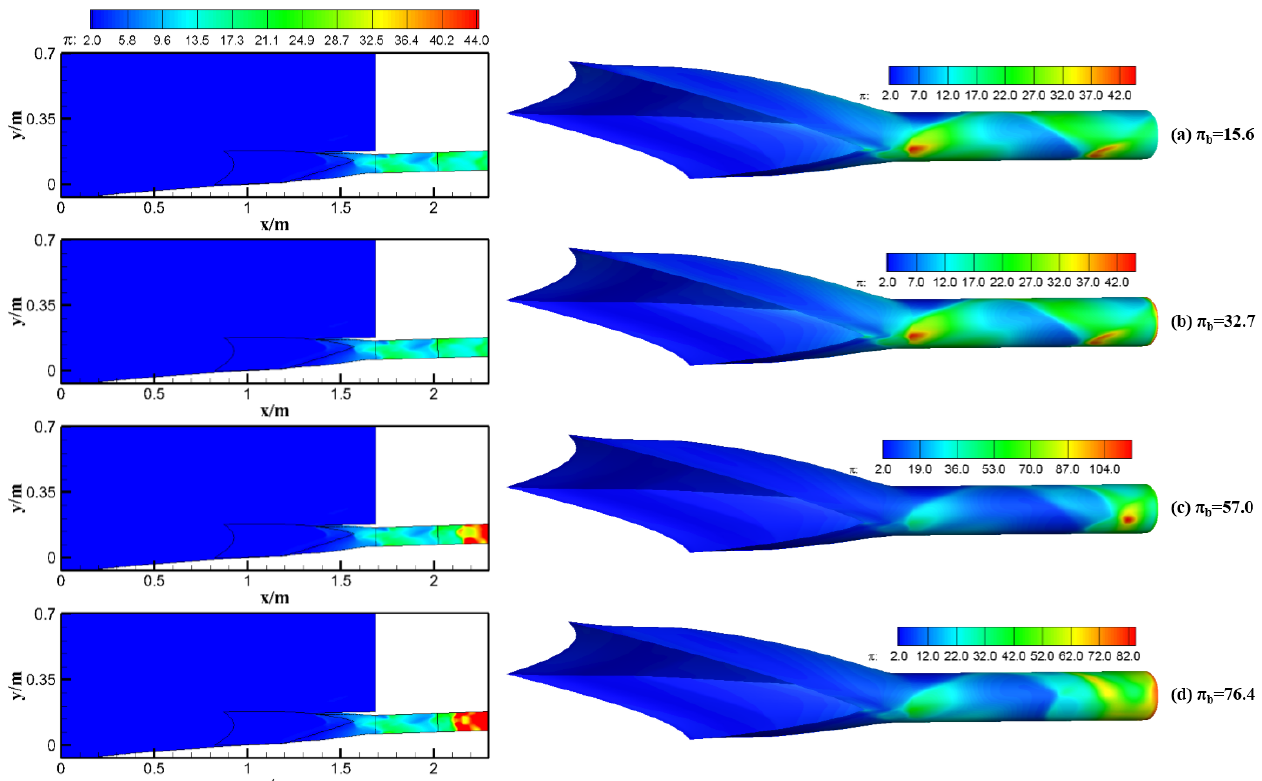
Figure 6. Pressure contours of the side-spillage integrated form ( πb = 15.6~76.4, Form 2). The speed distribution of Form 2 was studied under different backpressure condi- tions. As demonstrated in Figure 8, a series of streamlines of the near-wall region and the symmetry were obtained. The M distribution for nine longitudinal cross-sections was